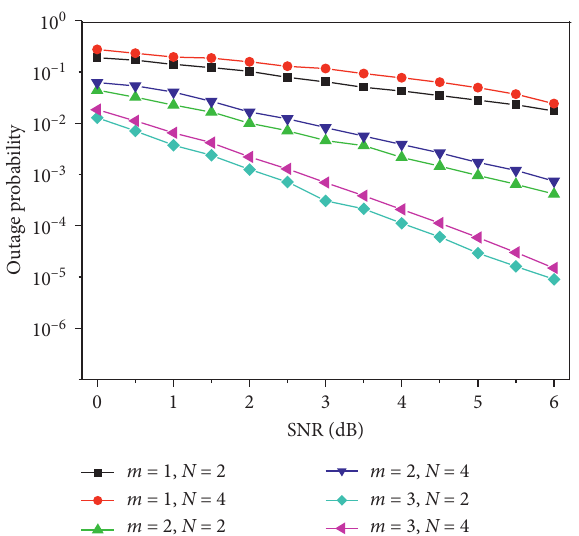
Figure 11: Comparison of outage probability results given different number of multihop path